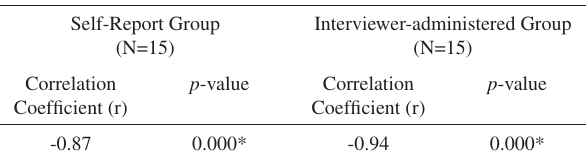
Table 3 - Pearson Correlation Coefficient between WORC and DASH in each group Self-Report Group